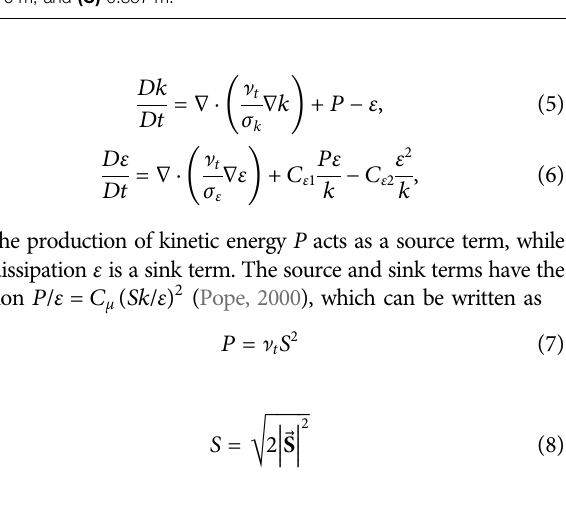
FIGURE 2 | Comparisons of time series of the free surface elevations between experimental and numerical results at three locations of (A) x (cid:2) − 0.657 m; (B) 0.010 m; and (C) 0.357 m.